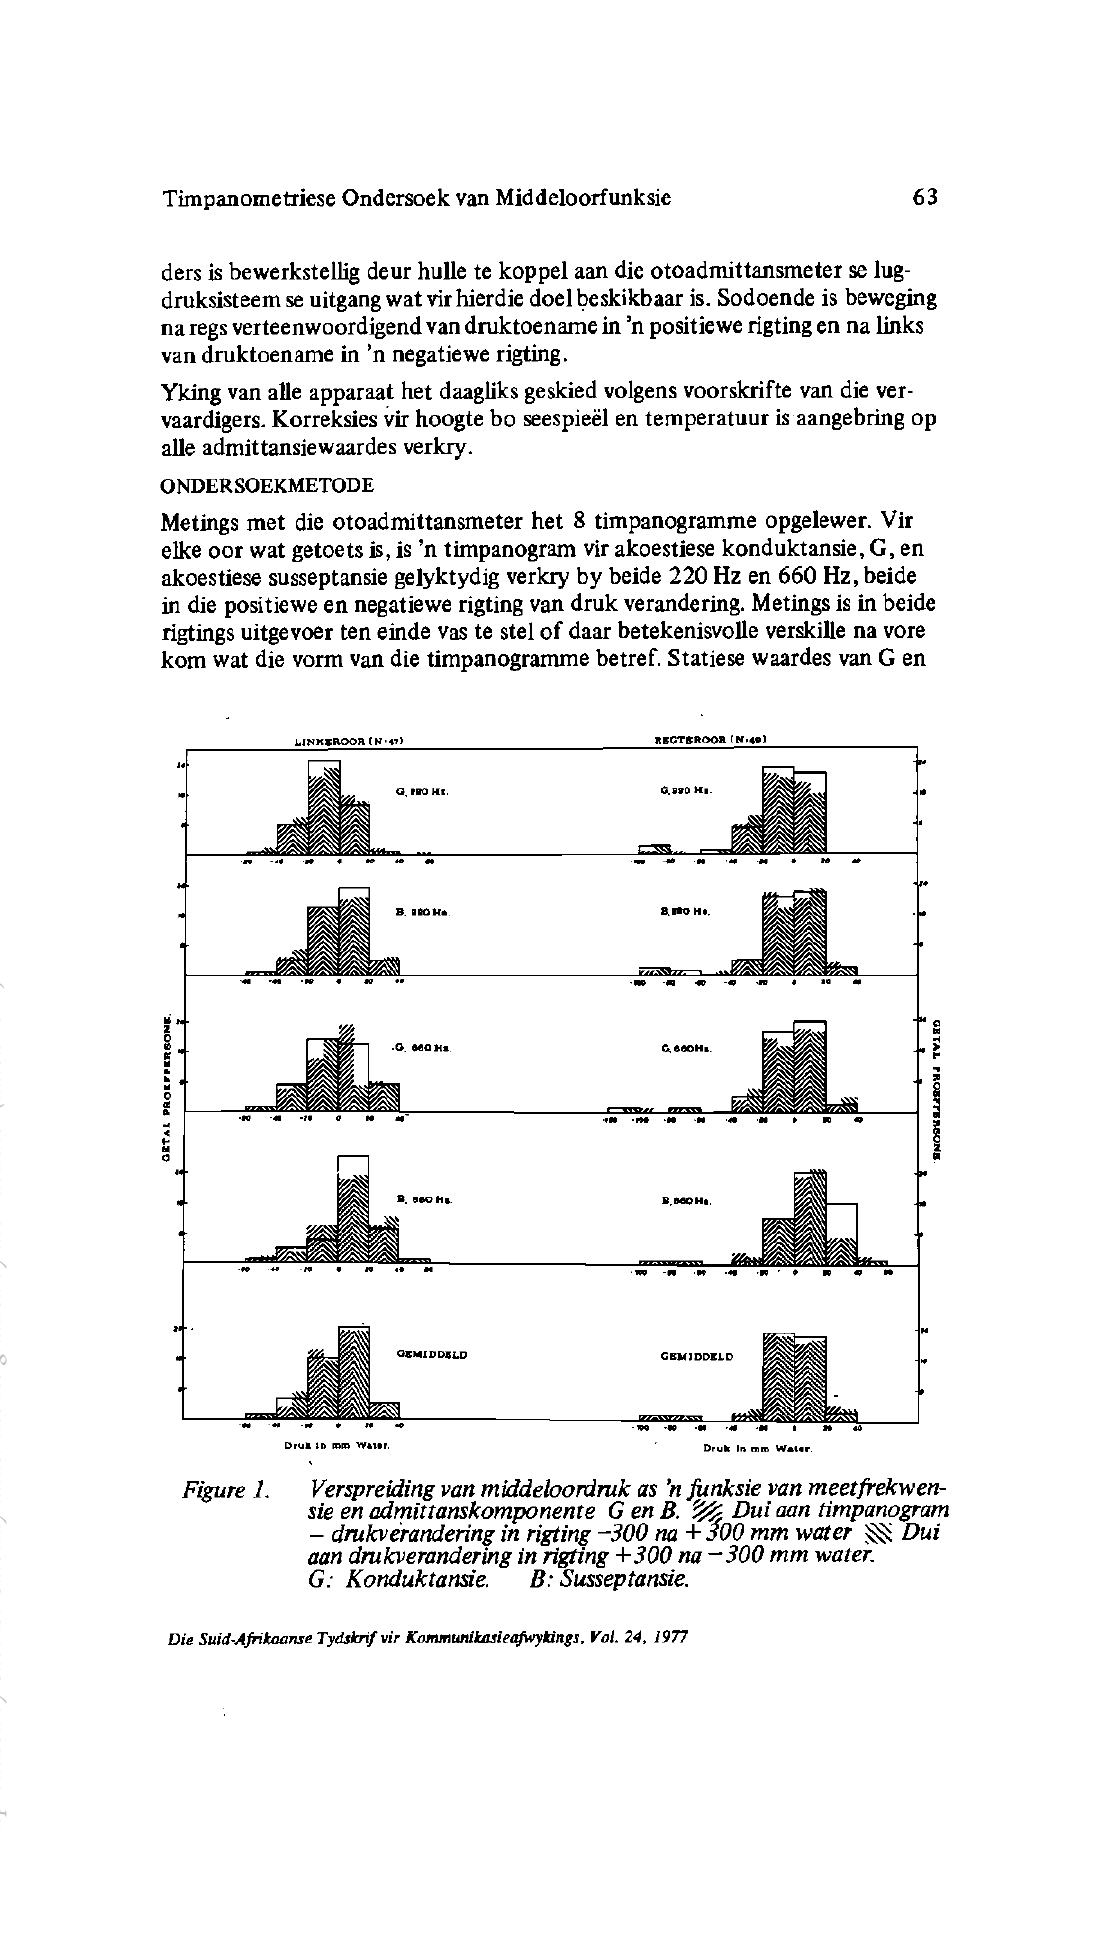
G: Konduktansie. B: